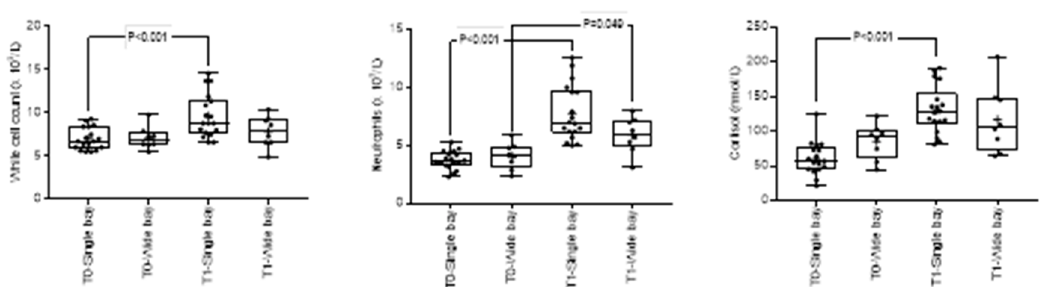
Figure 6. Effect of the interaction between space (single or wide bays) and time (T0, T1) on cortisol, white blood cell and neutrophil counts. Results are shown as mean ( ₊ ) and median (horizontal line), quartile (box) and range (whiskers), with all data points shown.